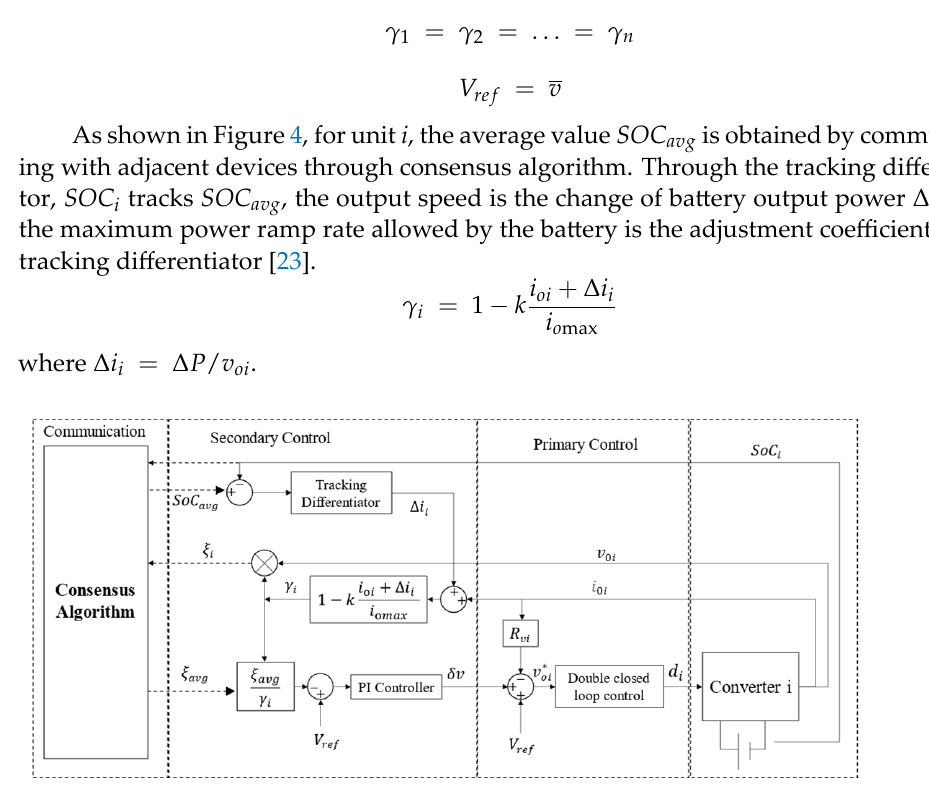
Figure 4. Hierarchical control diagram.